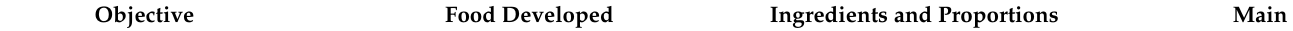
Table 4. Studies of tomatoes for the development of new